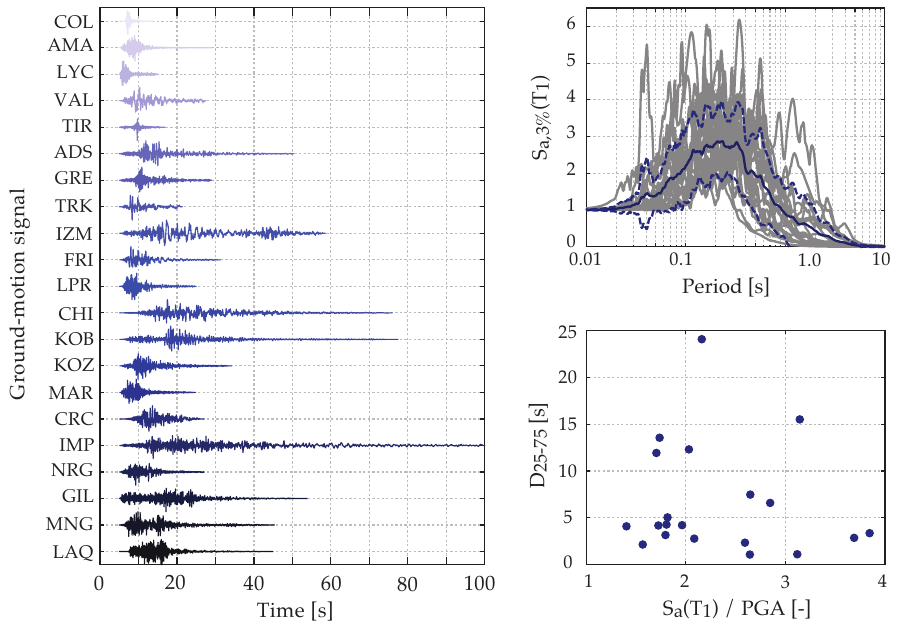
Figure 4. Overview of the GM signals used as input for the conducted nonlinear time-history analyses. The time-series of the 21 earthquakes are deliberately chosen to vary in duration ( left ), spectral content ( top right ), and intensity ( bottom right